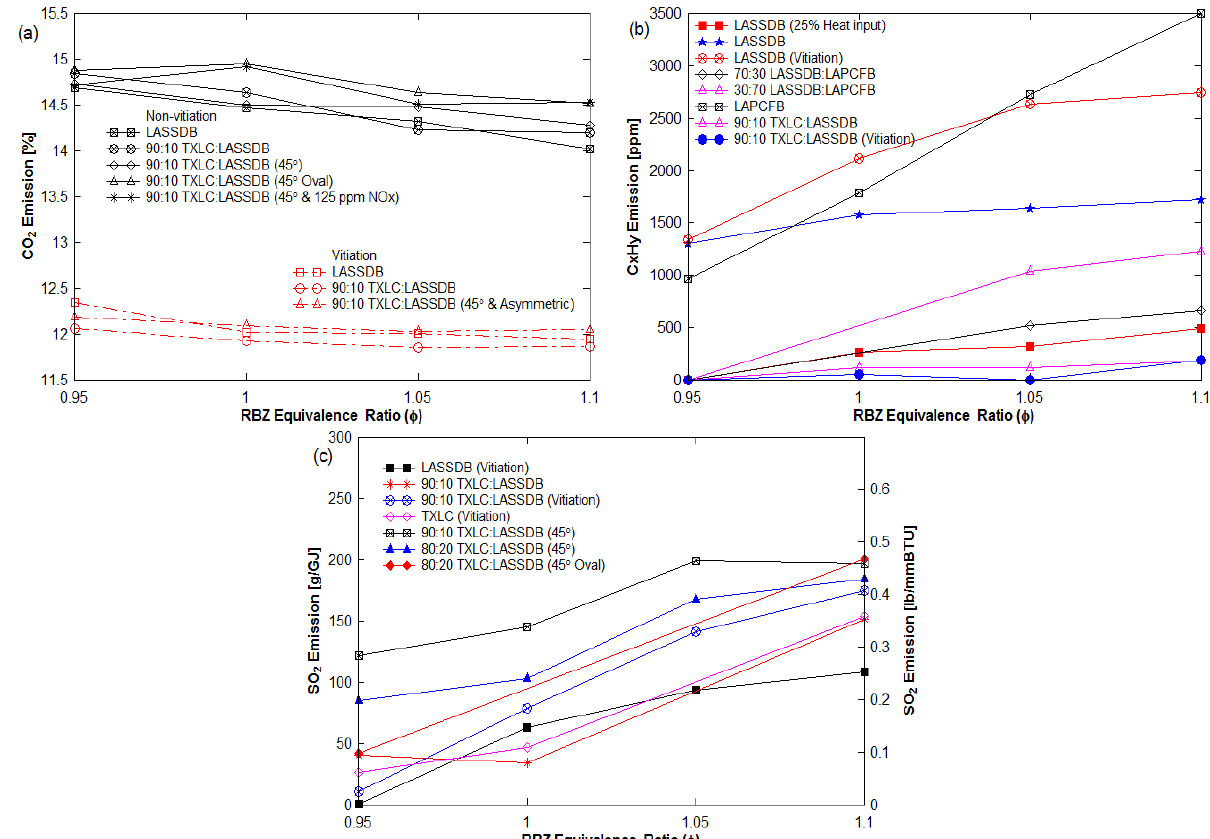
Figure 14. ( a ) CO 2 emissions, ( b ) C x H y emissions and ( c ) SO 2 emissions as a function of the ER RBZ . The C x H y (unburned hydrocarbons) emissions increased with the increase in ER RBZ , as shown in Figure 14b. C x H y is typically burned to CO 2 or water with enough oxygen. When the ER RBZ increases, the depletion of O 2 causes less combustion of C x H y and pro- duces less CO 2 and water. The results showed the combustion of biomass-only fuels pro- duced much more C x H y than the other reburn fuels. The results of the other fuels, blends of coal: biomass and coal-only fuels showed less than 100 ppm independent of the ER RBZ . The measurement of SO 2 was interfered with by water condensed in the probe of the gas analyzer. Stable measurements of SO 2 emissions were presented in Figure 14c. The SO 2 emissions increased with the increase in ER RBZ . Since SO 2 is readily soluble to the cold water, more SO 2 emissions should be detected in the lower water production case. With the increase in ER RBZ , less water was produced from C x H y ; hence, a higher level of SO 2 was detected. 3.5. Burnt Fraction (BF) The variation in ER in RBZ causes a change in BF of the reburn fuels due to the change in proportions of moisture, ash, and combustibles (volatile matter and fixed carbon). Prox- imate and ultimate analyses for reburn fuels are presented in Table 2. Combustibles in fuels are 80.03% for LASSDB, 79.47% for LAPCFB and 81.41% for TXLC on a dry basis. In order to determine the BF, the bottom ash was collected from the ash port filled with water at the furnace bottom. The BF is defined as the ratio of combustibles burnt to the initial combustible mass. The BF was determined on a dry basis using the ash tracer method, which uses the % ash in RF prior to and after combustion [35]. The results of the BF are listed in Table 7: 64.15% for pure TXLC, 65.78% for 90:10 TXLC:LASSDB, 70.39% for 80:20 TXLC:LASSDB, 85.29% for LASSDB, and 88.90% for LAPCFB. The majority of lighter fly ash particles in the gas stream flowed into the exhaust